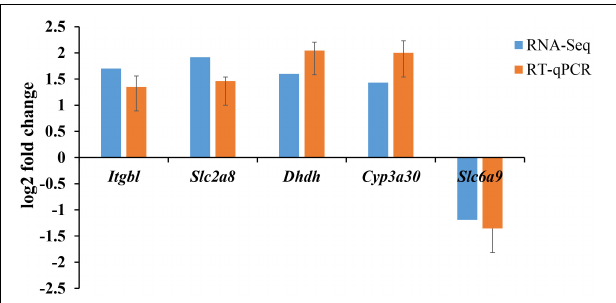
FIGURE 4 | RT-qPCR verification of five target genes identified as differentially expressed between normal and moribund groups of Fenneropenaeus chinensis in 10 ppt salinity environment. Four genes ( Itgbl , Slc2a8 , Dhdh , Cyp3a30 ) were upregulated in normal shrimp compared to moribund shrimp, one gene ( Slc6a9 ) was downregulated, as we excepted.